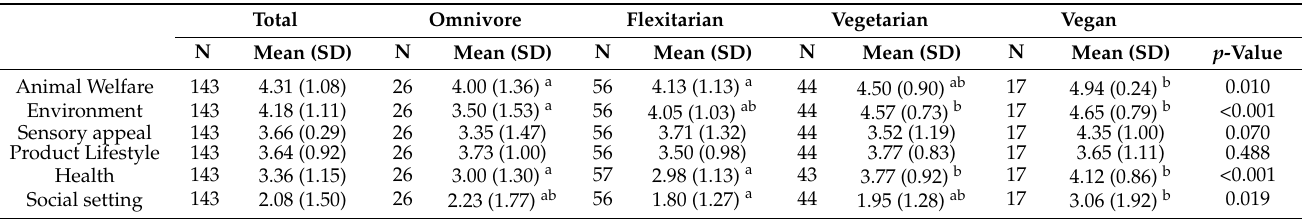
Table 9. Motives for purchasing PBMiAs 1 by diet measured on a 5-point-scale (1 “totally disagree”, 5 “totally